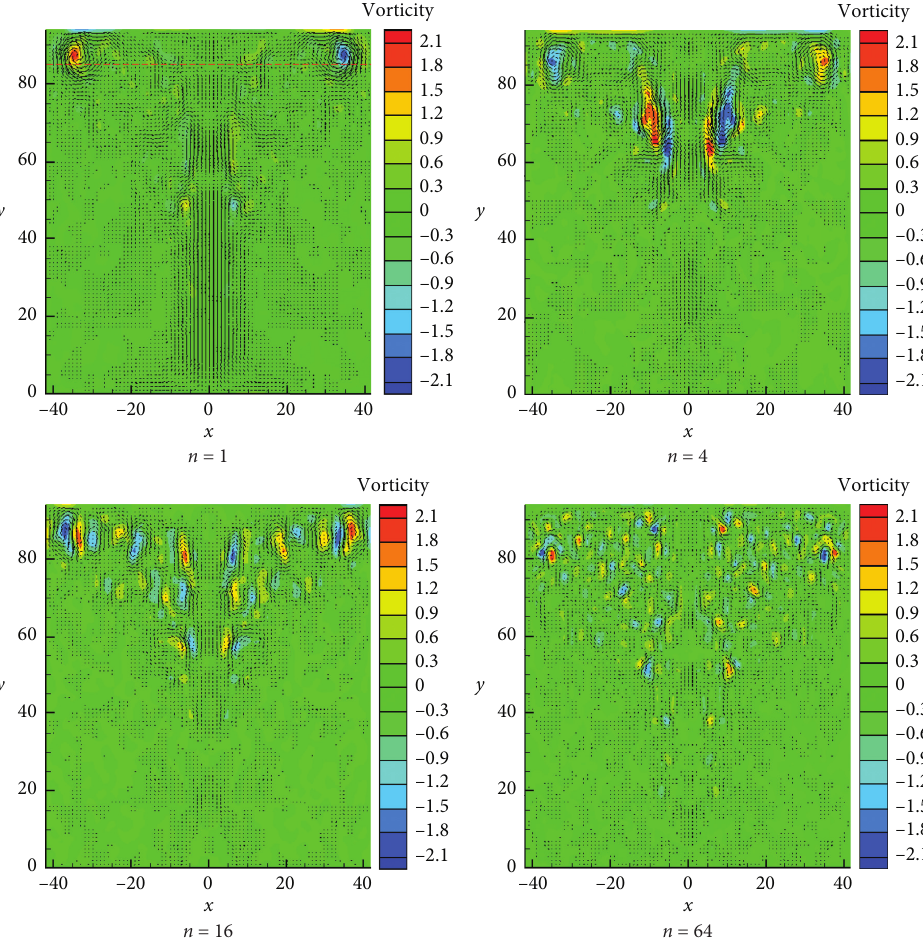
Figure 12: The single POD mode at 40g oscillation acceleration under 90% fill